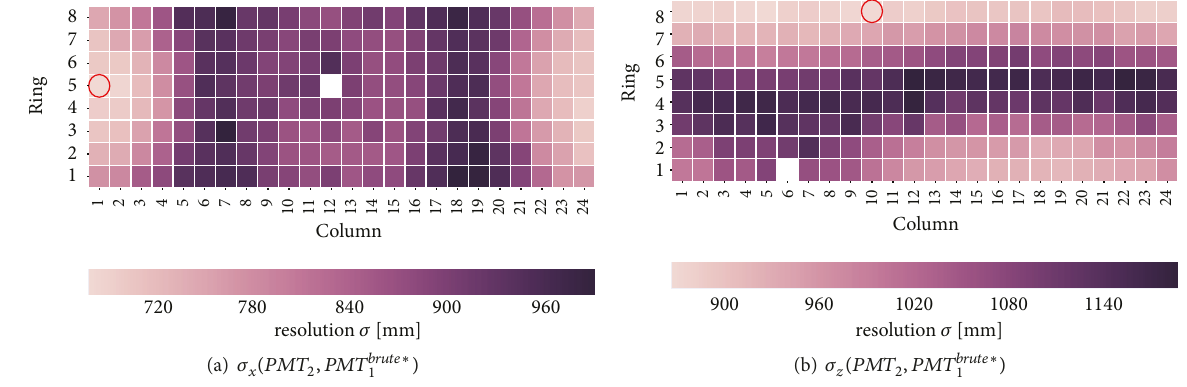
Figure 5: Resolution 𝜎 corresponding to using the charge information from the most important PMT as identified previously and a second candidate PMT for (a) 𝑥 and (b) 𝑧 . The first PMT as found by the previous round, 𝑃𝑀𝑇 𝑏𝑟𝑢𝑡𝑒∗ 1 , using the brute force search is whitened in each figure. In each of the heatmap, the circled PMT, 𝑃𝑀𝑇 ∗ 2 , corresponds to the best resolution when considering the said PMT and the first important PMT found previously for the vertex